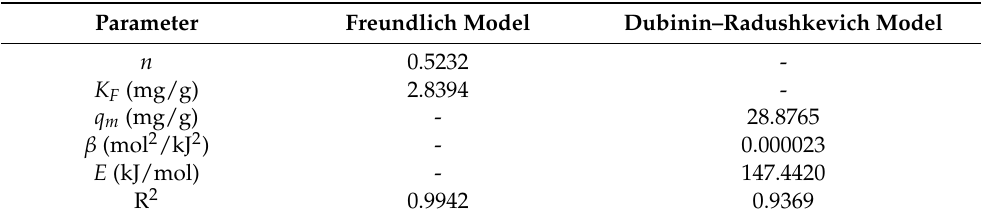
Table 2. Freundlich and Dubinin–Raduschkevich isotherm models of EL biosorption process on Saccharomyces pastorianus /calcium alginate